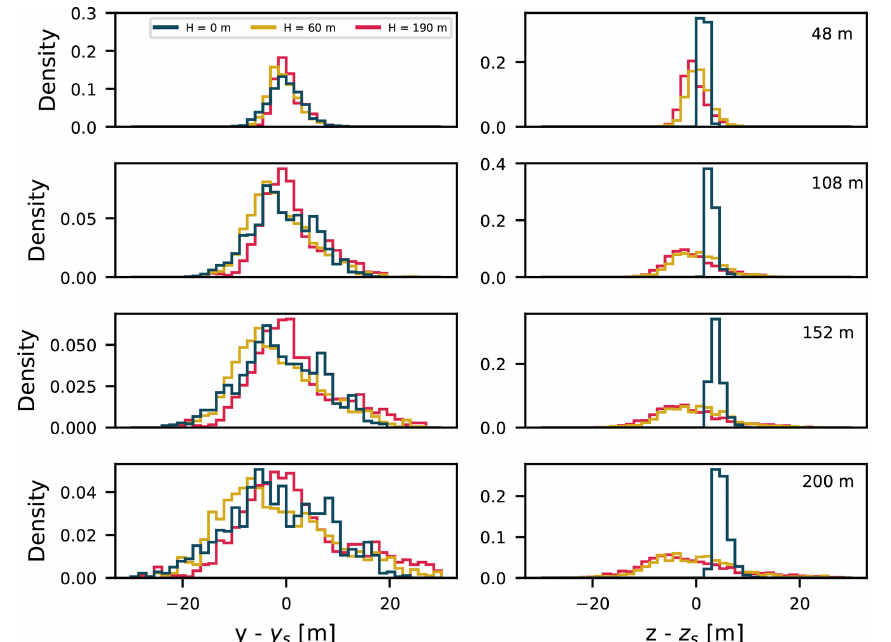
Figure 9. Probability density functions of the instantaneous-plume centerline positions with respect to the plume emission positions (blue: 0m; yellow: 60m; pink: 190m) in the y (left column) and z (right column) directions. Bins of 1.5m are